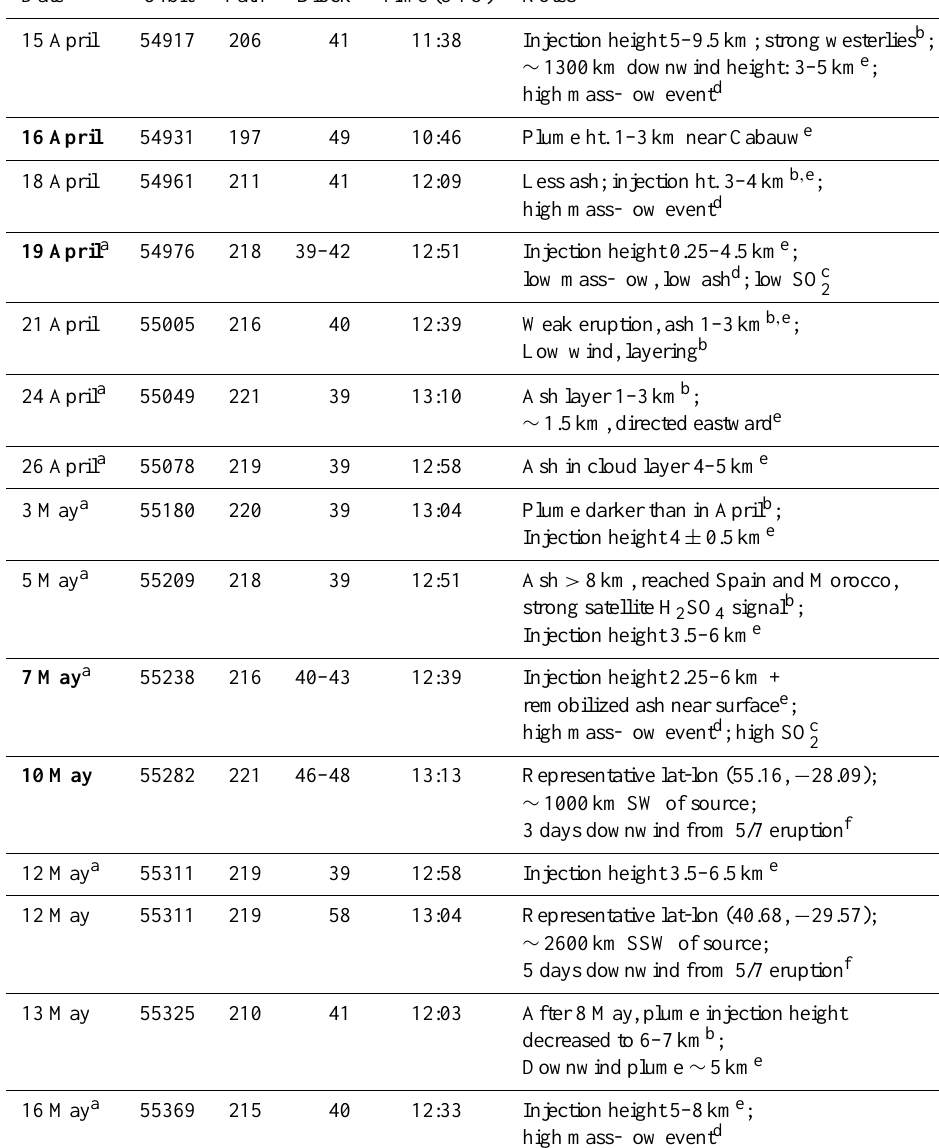
Table 1. MISR observations of the during the Eyjafjallaj¨okull plume during the study period. Date Orbit Path